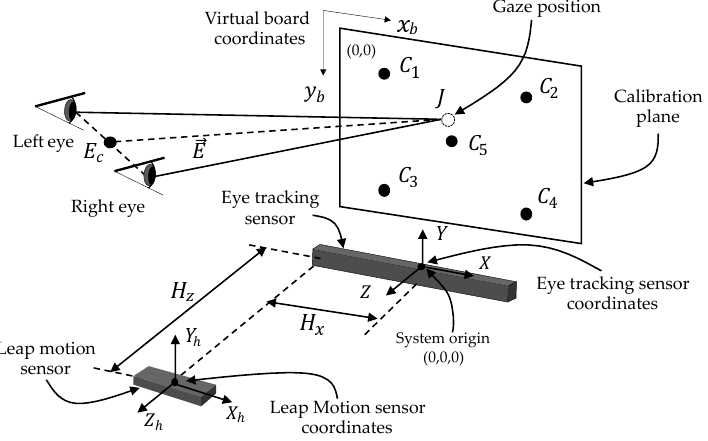
Figure 12. System